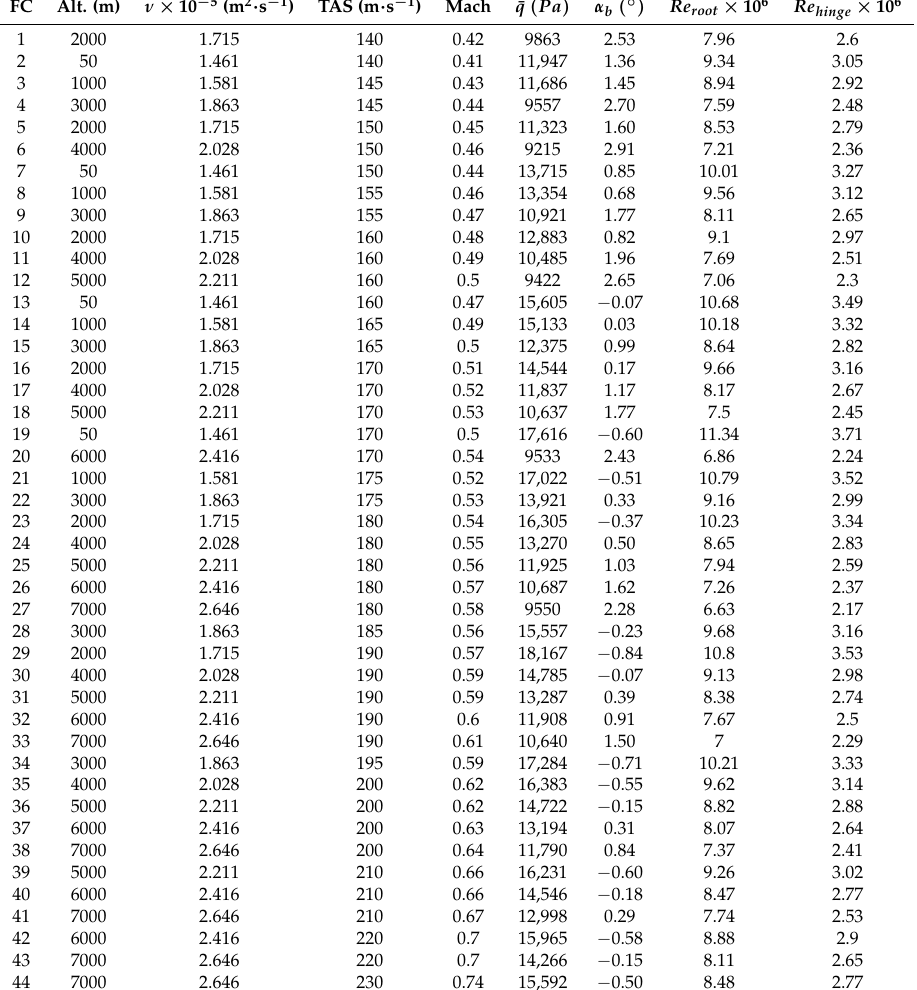
Table A1. Range of simulation parameters for the entire set of flight conditions